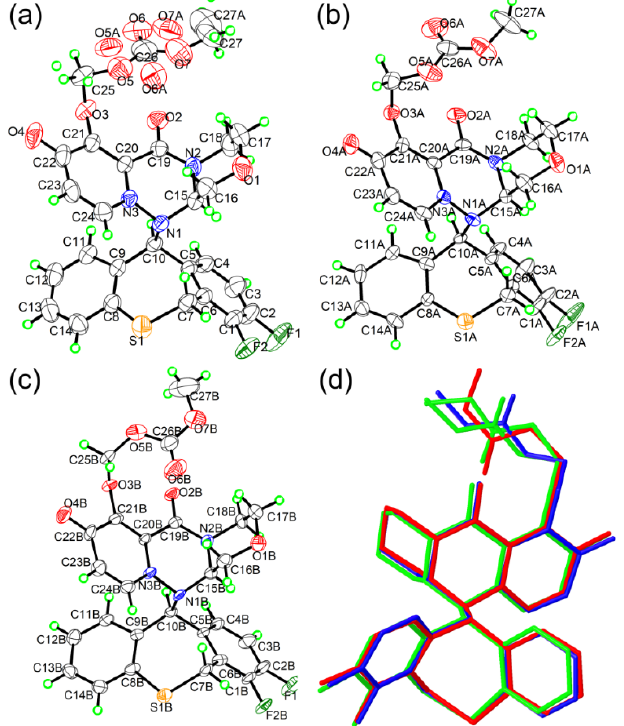
Figure 2. The ORTEP figures of ( a ) Form I, ( b ) molecule A of Form II, and ( c ) molecule B of Form II drawn at the 50% probability level. H atoms are shown as small spheres at a 0.15 Å radius. ( d ) Superposition of the BXM in I (green), molecule A (red), and molecule B (blue) in II. Hydrogen atoms were omitted for clarity.